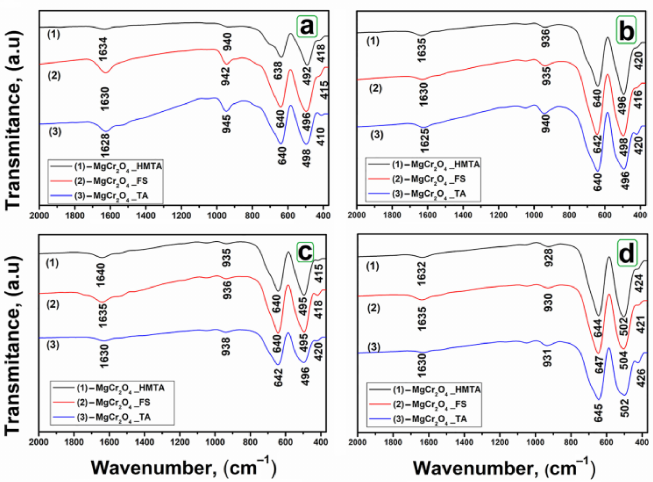
Figure 1. FTIR spectra recorded at ambient temperature after annealing the samples at 500 ◦ C ( a ), 700 ◦ C ( b ), 750 ◦ C ( c ), and 900 ◦ C ( d